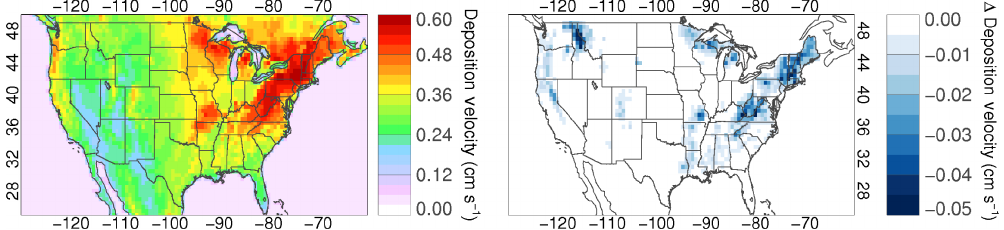
Figure 5. Mean JJA O 3 deposition velocity in the base scenario (left), and the change in deposition velocity resulting from predicted tree mortality